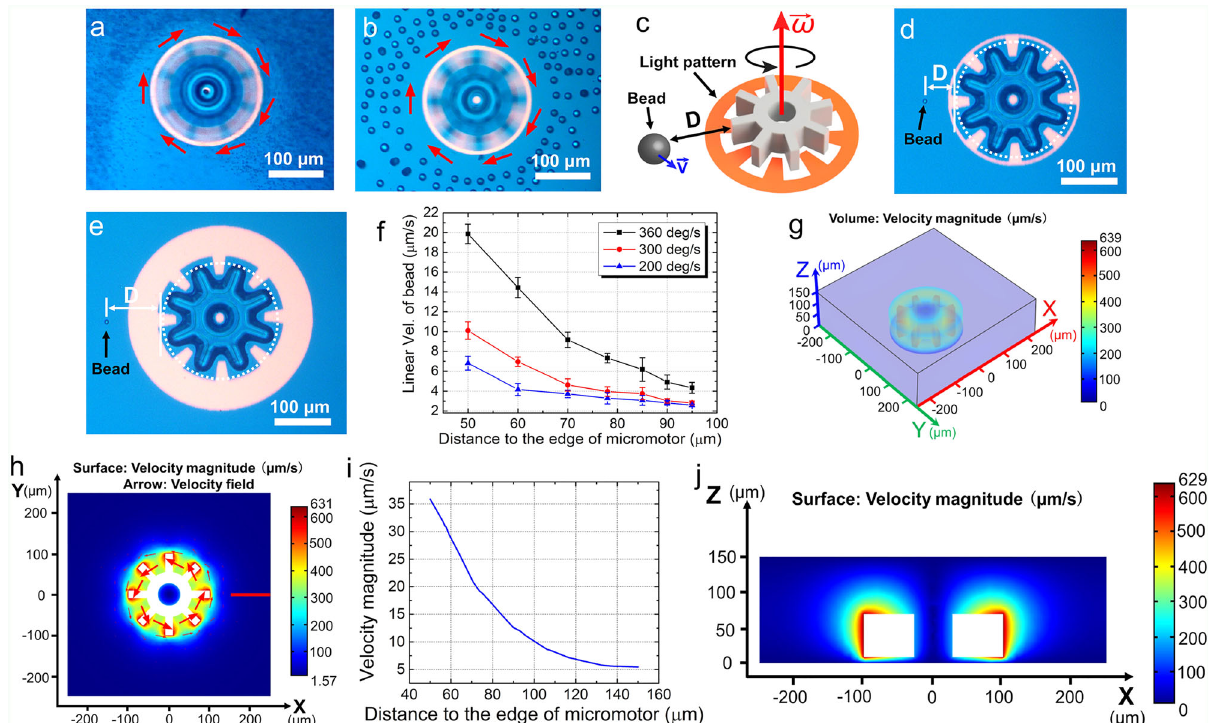
Fig. 3 Micromotor impellers. Frames from Supplementary Movie 5 of a micro-gear rotating at 360°/s in a suspension of a 1- μ m-diameter and b 15- μ m- diameter polystyrene microbeads. Red arrows indicate the direction of rotation of the micro-gear and revolution of the particles. c Schematic of a rotating micro-gear (with angular velocity ω ) and its in fl uence on a nearby particle (with linear velocity v ), and distance D between the two. Microscope images of a 7- μ m-diameter polystyrene microbead and a micro-gear with d D = 50 μ m and e D = 95 μ m. f Linear velocities of 7- μ m-diameter beads revolving around rotating micro-gears as a function of D for micro-gears rotated at 200°/s (blue triangles), 300°/s (red circles), and 360°/s (black squares). Error bars represent ±1SD from three measurements for each condition. 3D ( g ), 2D ( h ), 1D ( i ), and 2D ( j ) plots of numerical simulation of the velocity of fl ow (in μ m/s) around a micro-gear rotating at 360°/s after 2s of rotation. Velocities in ( g , h , and j ) are shown as a heat map from 0 μ m/s (blue) to over 600 μ m/s (red), and arrows in ( h ) are velocity vectors. h is an XY slice from ( g ) at Z = 11 μ m, i is an X slice of ( h ) [denoted by the red line in ( h )], and j is an XZ slice from ( g ) at Y = 0 μ m (the white boxes denote the position of the